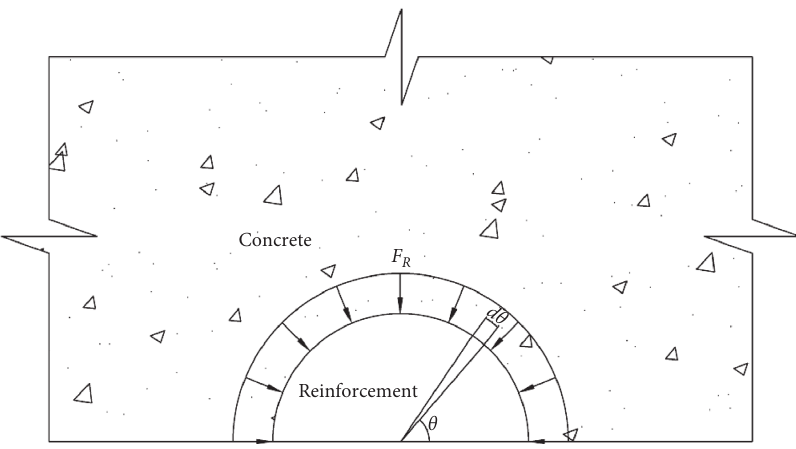
Figure 16: The force on reinforcement. Table 4: Parameter of the concrete damage